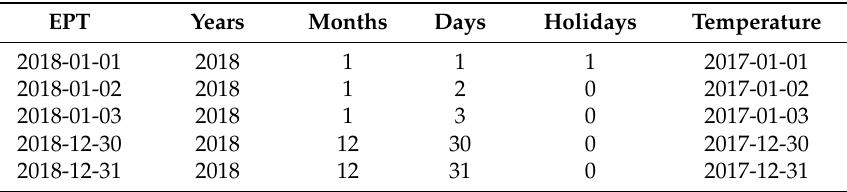
Table 7. Dates of variable used as a basis for forecasting the amount of EPT. EPT Years Months Days